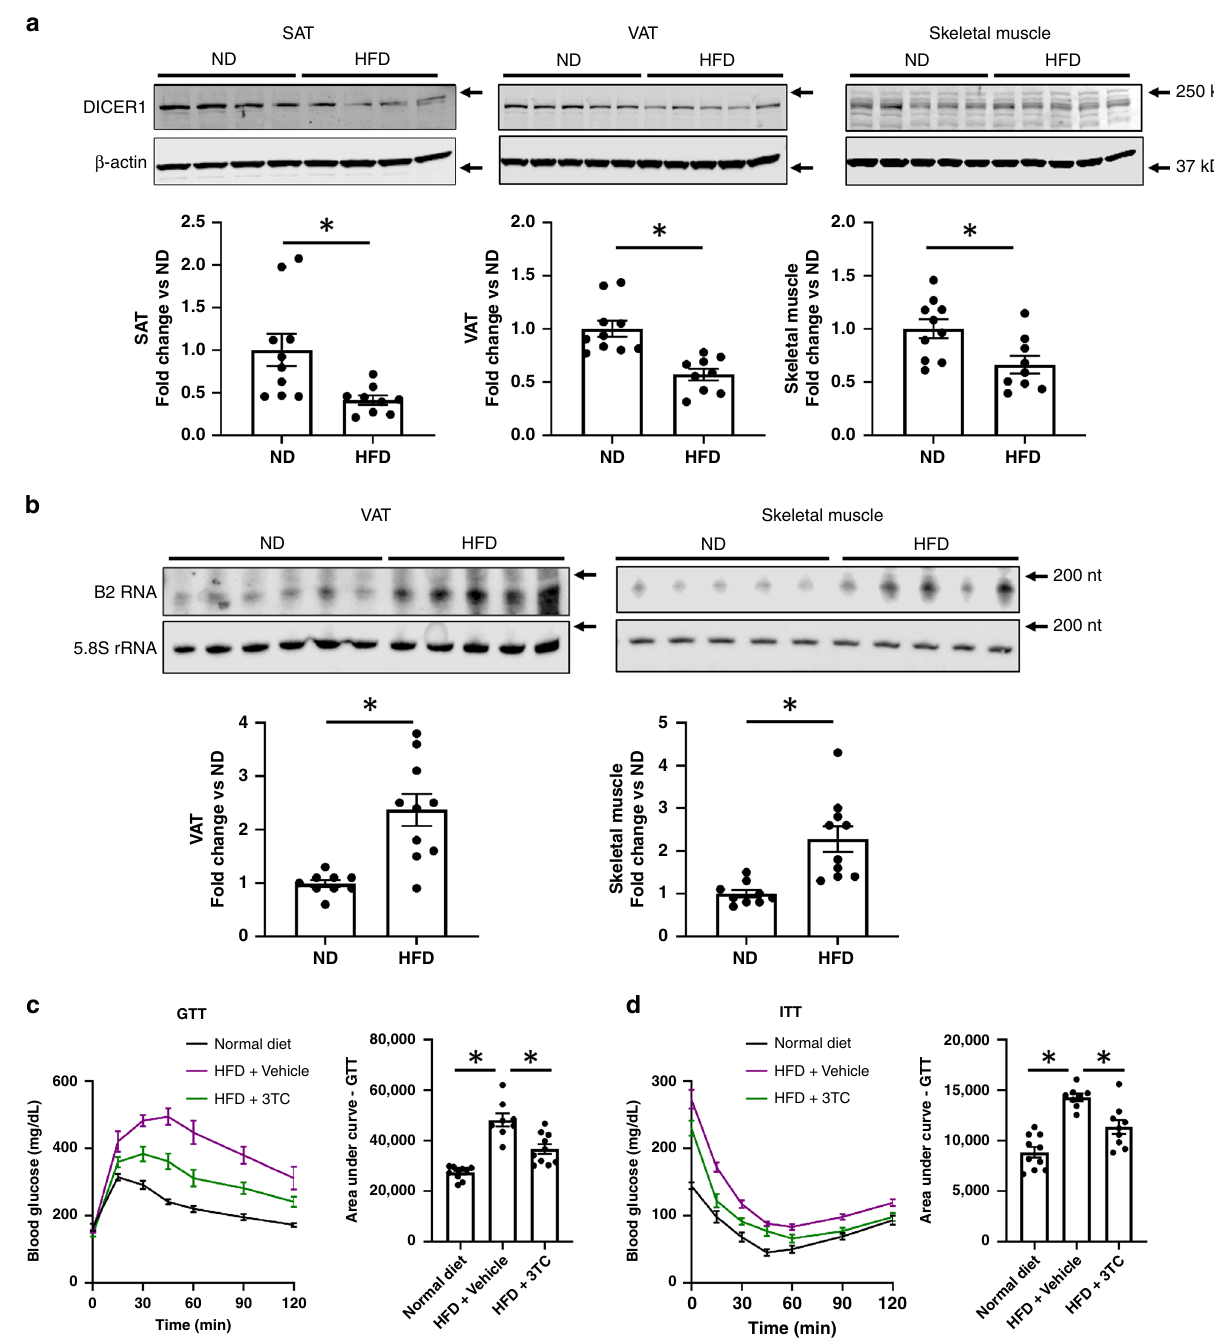
Fig. 5 Expression of DICER1, B2, and insulin sensitivity in high-fat diet-fed mice. a The top three panels show the results of western blotting of extracts of proteins from subcutaneous adipose tissue (SAT), visceral adipose tissue (VAT), and skeletal muscle tissue isolated from mice fed a normal diet (ND) or a high-fat diet (HFD). Immunoreactive bands corresponding to DICER1 and beta-actin ( β -actin) are shown. The bottom three panels show bar graphs of the densitometric analyses of the DICER1 western blots in the top panels that have been normalized to β -actin abundance and to the ND group data. n = 10 (ND) or 9 (HFD) samples per group. * P = 0.01 (ND versus HFD in SAT), P <0.001 (ND versus HFD in VAT), P = 0.01 (ND versus HFD in Skeletal muscle), two-tailed unpaired Student t test. b The top two panels show the results of northern blotting of total RNA extracts from visceral adipose tissue (VAT) and skeletal muscle tissue isolated from mice fed a normal diet (ND) or a high-fat diet (HFD). Hybridization bands corresponding to B2 RNA and 5.8S ribosomal RNA (5.8S rRNA) are shown. The bottom two panels show bar graphs of the densitometric analyses of the B2 northern blots in the top panels that have been normalized to 5.8S rRNA abundance and to the ND group data. n = 9 (ND) or 10 (HFD) samples per group. * P <0.001 (ND versus HFD in VAT) and P = 0.001 (ND versus HFD in Skeletal muscle), two-tailed unpaired Student t test. Glucose tolerance test (GTT; c ) and insulin tolerance test (ITT; d ) measurements, and area under the curve (AUC) quanti fi cation in mice fed a normal diet, a high-fat diet and treated with phosphate-buffered saline vehicle (HFD + Vehicle), or a high-fat diet and treated with once-daily intraperitoneal administration of lamivudine (70mg/kg of body weight) (HFD + Lam). Data are reported as mean±s.e.m. n = 10 (ND), 8 (HFD + Vehicle), or 10 (HFD + Lam) samples per group c . n = 10 (ND), 8 (HFD + Vehicle), or 9 (HFD + Lam) samples per group d . *In GTT, P <0.001 (HFD + Vehicle versus Normal Diet) and P = 0.002 (HFD + 3TC versus HFD + Vehicle), two-tailed unpaired Student t test. *In ITT, P <0.001 (HFD + Vehicle versus Normal Diet) and P = 0.003 (HFD + 3TC versus HFD + Vehicle), two-tailed unpaired Student t test. Source data are provided as a Source Data fi